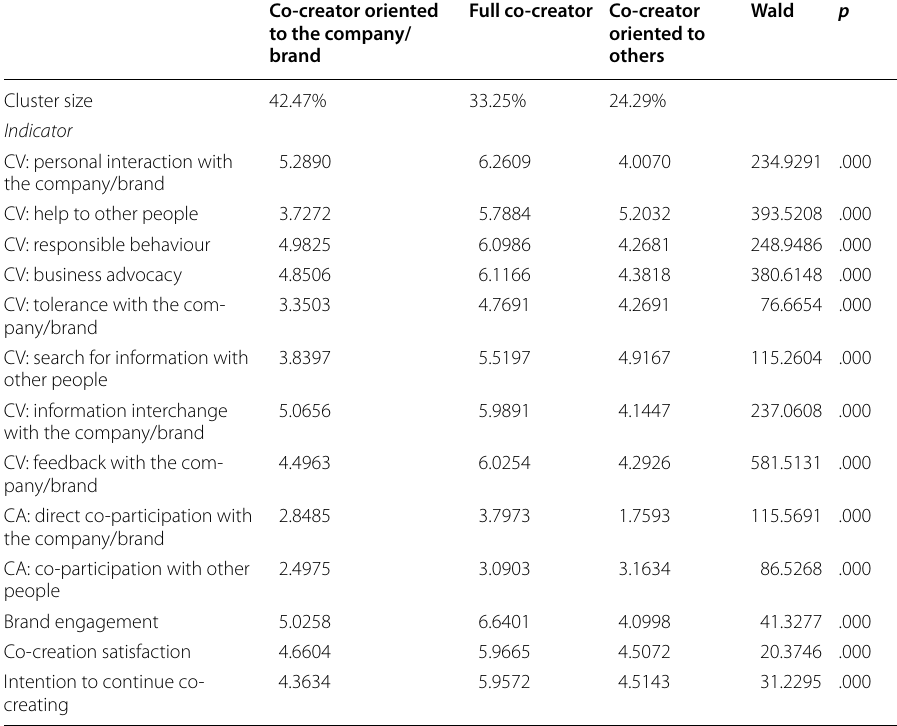
Table 9 Profile of segments of co‑creators (indicators)